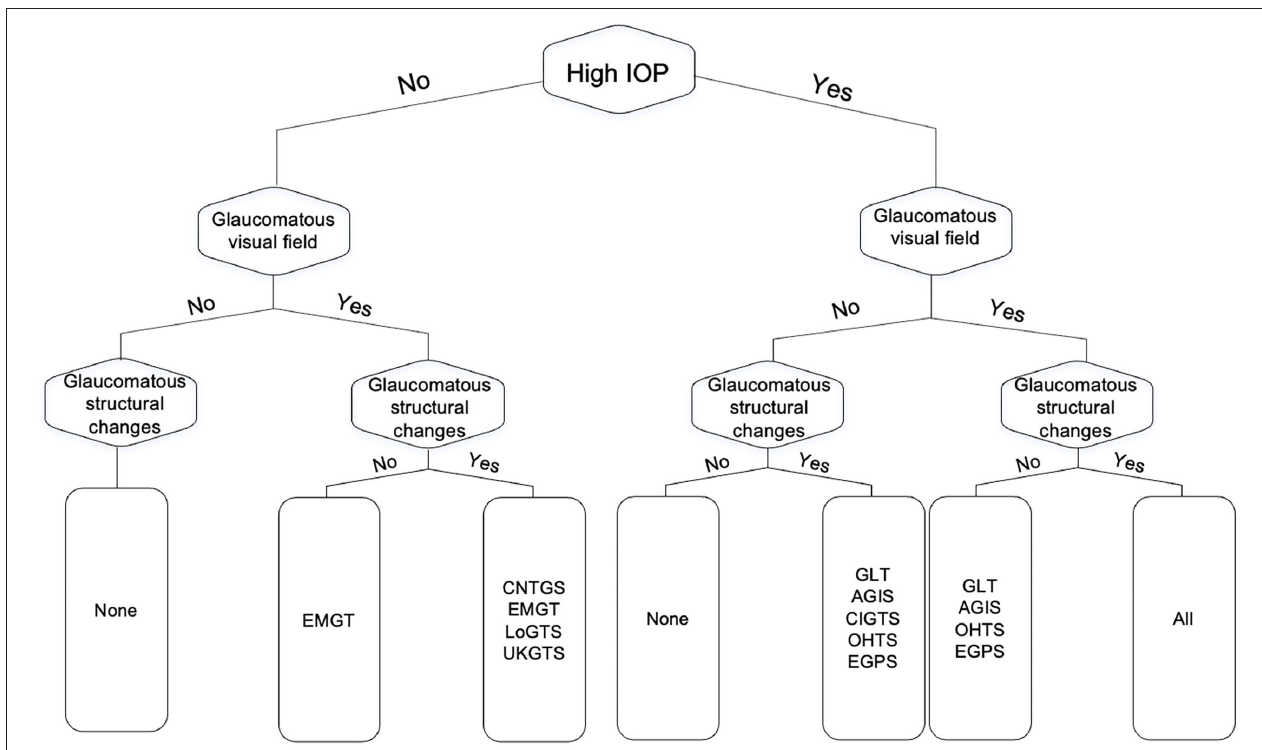
FIGURE 1 | Flow chart of the different combinations from the three glaucoma diagnostic facets (functional, structural, and intraocular pressure) as they relate to the major clinical trials in glaucoma. GLT, The Glaucoma Laser Trial; AGIS, The Advanced Glaucoma Intervention Study; CNTGS, Collaborative Normal-Tension Glaucoma Study; OHTS, Ocular Hypertension Treatment Study; EMGT, Early Manifest Glaucoma Trial; EGPS, The European Glaucoma Prevention Study; LoGTS, Low-Pressure Glaucoma Treatment Study; UKGTS, UK Glaucoma Treatment